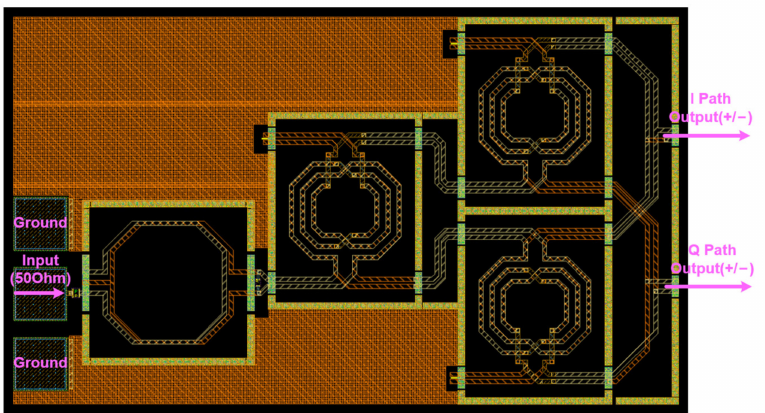
Figure 12. Layout of the proposed ultra-wideband quadrature signal generation network.